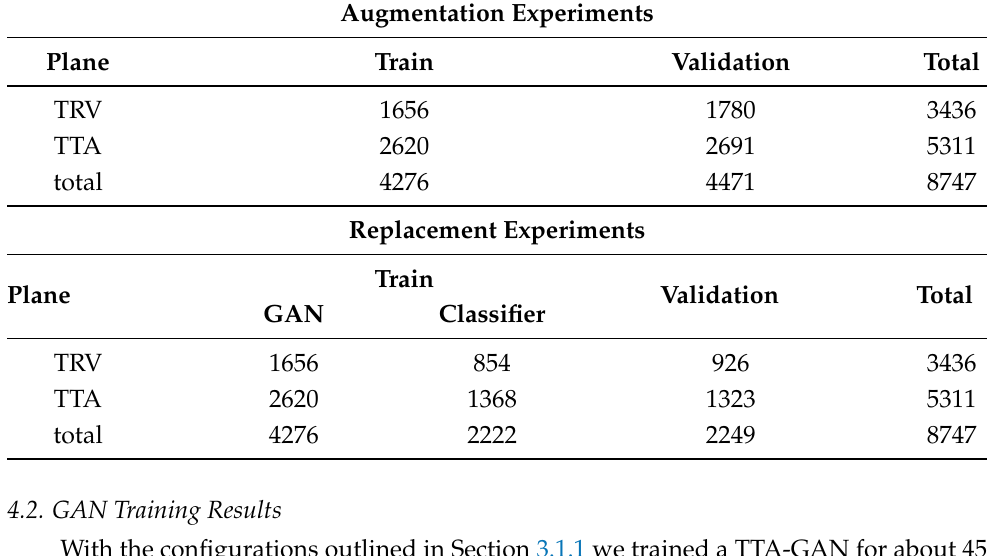
Table 1. Train/validation split with no overlapping patient samples used in augmentation and replacement experiments.